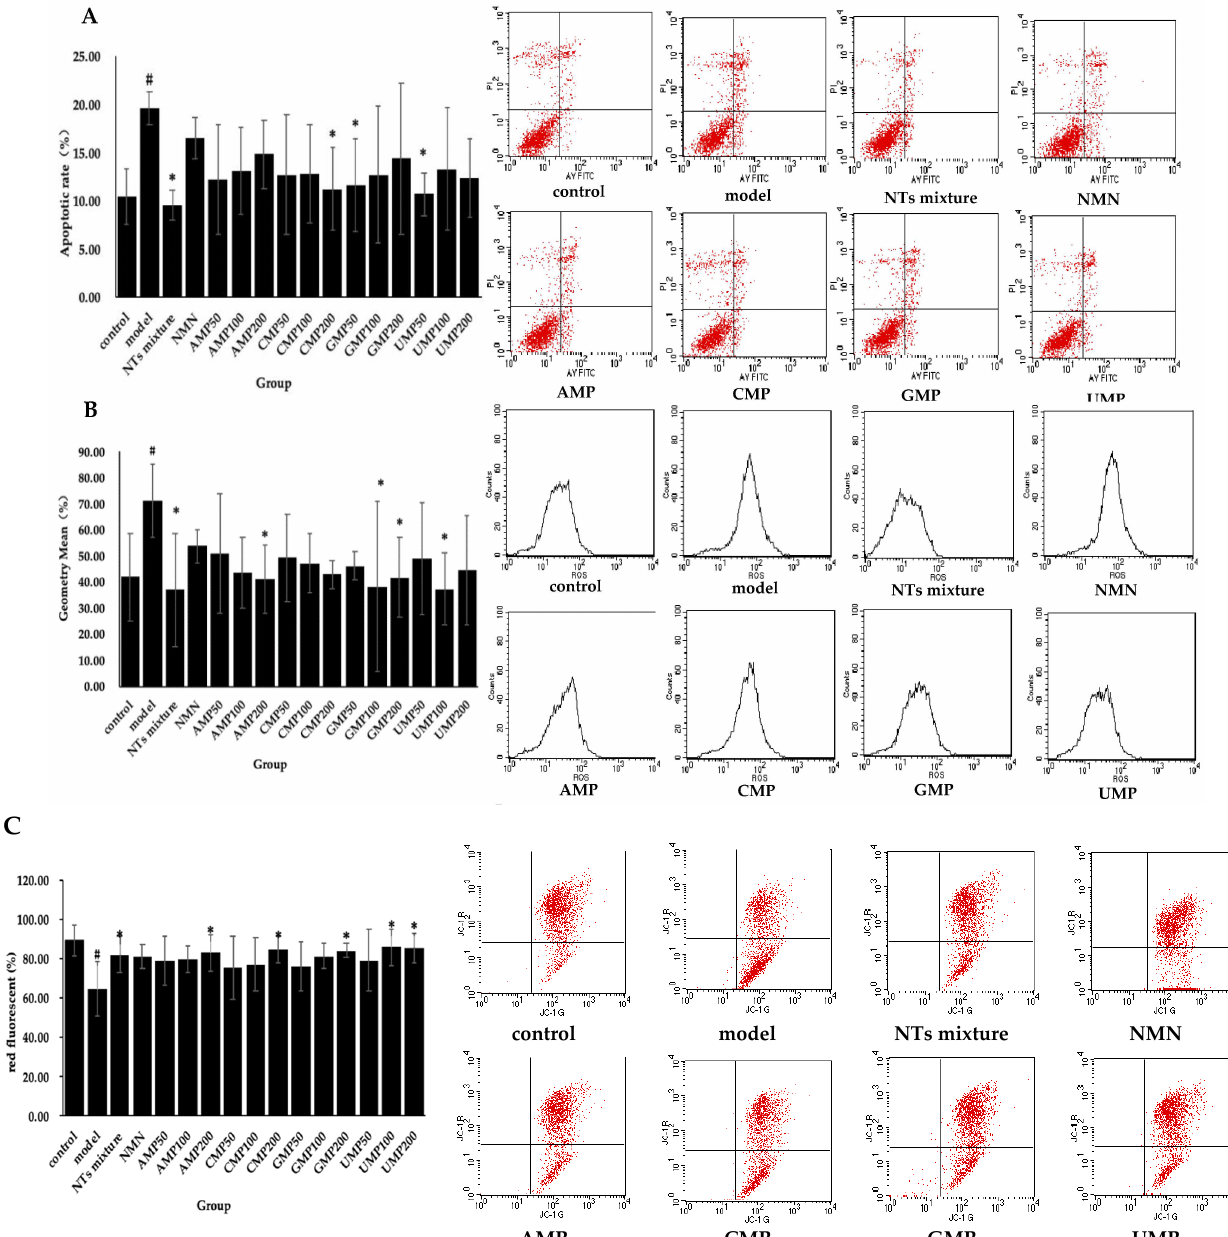
Figure 2. Effect of NTs on senescent HUVECs apoptotic rate, intracellular ROS production, and mitochondrial membrane potential. ( A ) Effect of NTs on senescent HUVECs apoptotic rate; ( B ) Effect of NTs on senescent HUVECs intracellular ROS production; ( C ) Effect of NTs on senescent HUVECs mitochondrial membrane potential. Values represented the mean ± S.D. ( n = 3 per group). # p < 0.05 versus control group, * p < 0.05 versus model group.